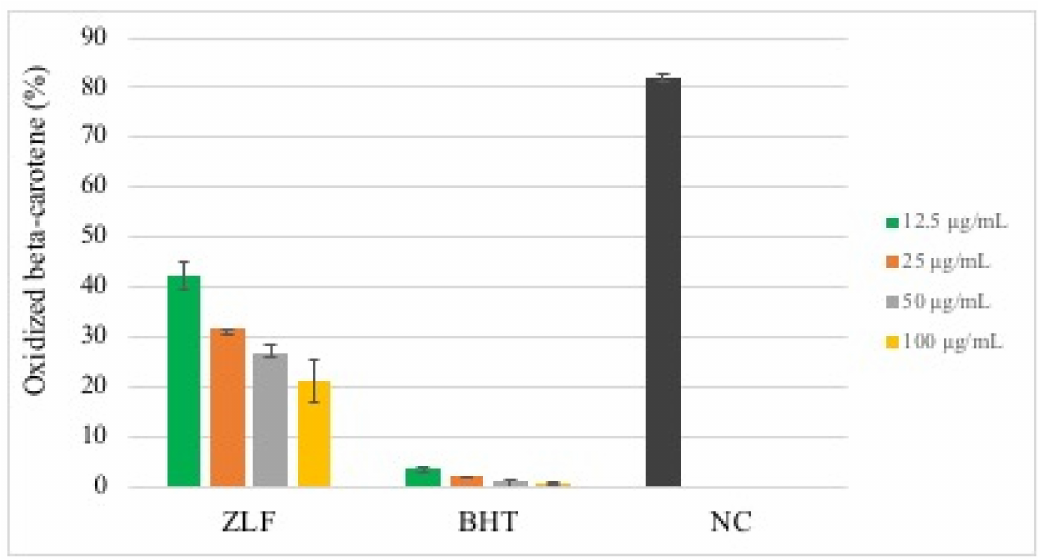
Figure 3. Effect of aqueous ZLF extract on β -carotene oxidative bleaching, NC: negative control; butylated hydroxy- toluene